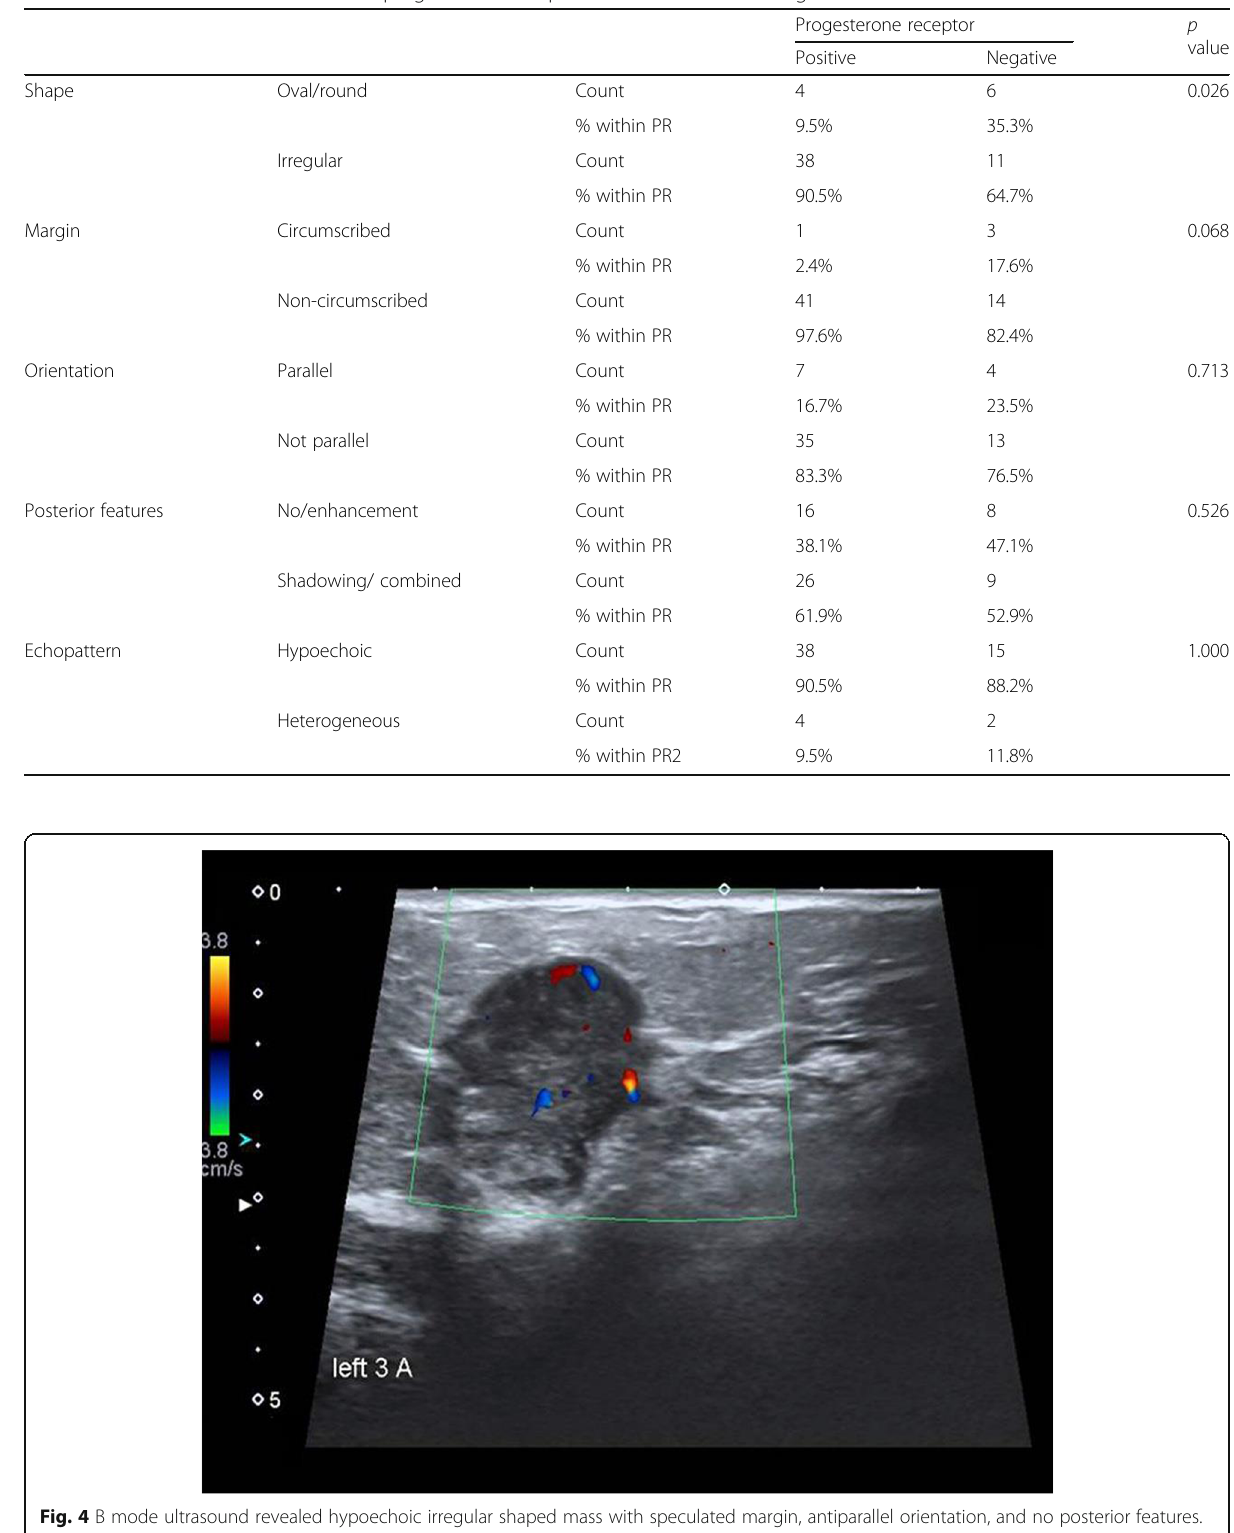
Table 5 Association between status of progesterone receptors and ultrasound findings of breast cancer